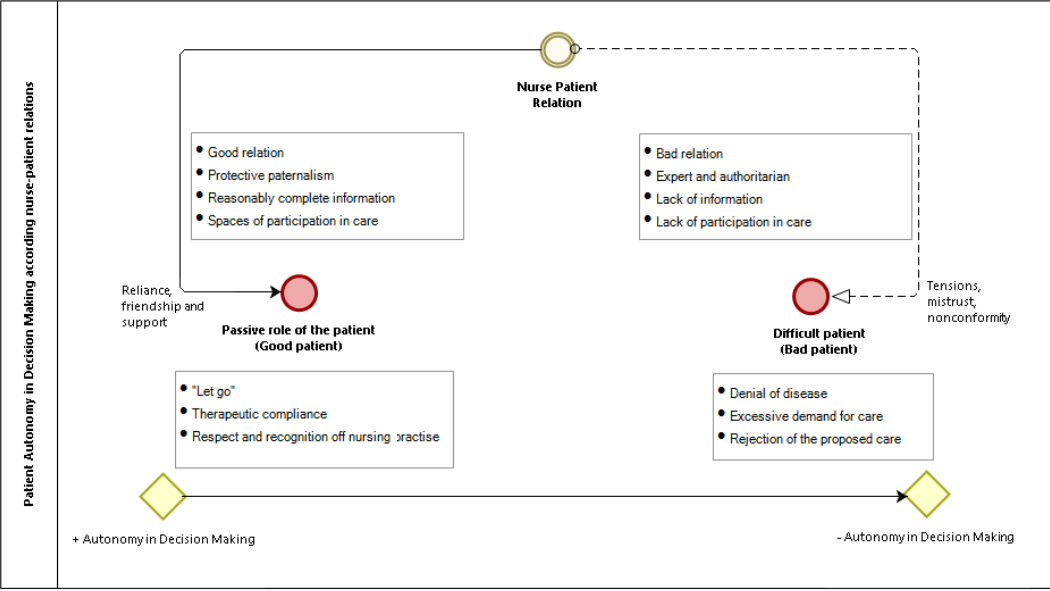
Figure 1. Autonomy in the decision-making of the patient according to the relationship with the nurse.